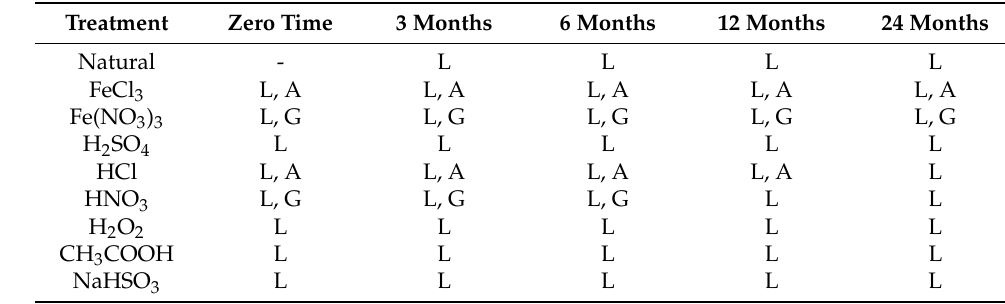
Table 5. Oxi-hydroxides identified by Raman spectroscopy in the surface of WS patinas (natural and accelerated patinas) at zero time and after 3, 6, 12 and 24 months of exposure in the urban atmosphere of Madrid.